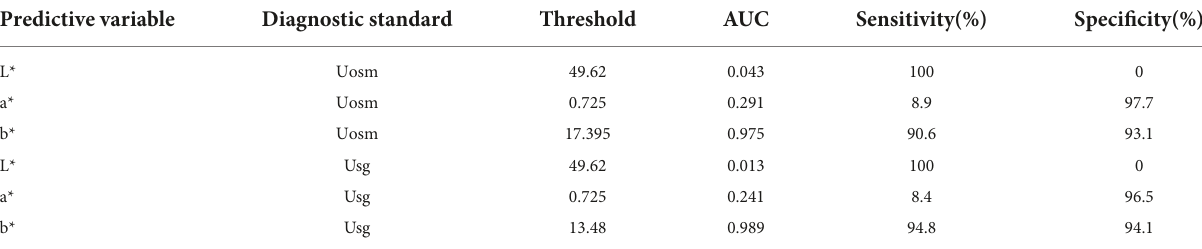
TABLE 3 ROC curve analysis of urine colour L*a*b* to identify